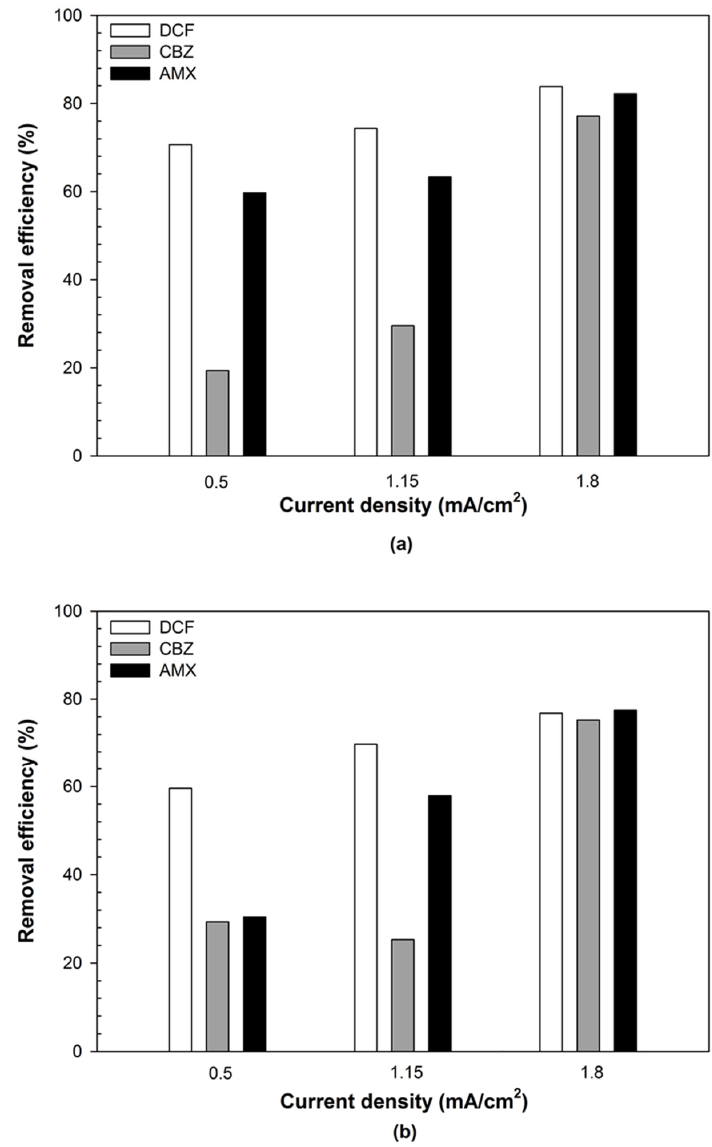
Figure 3. Effects of current density on the removal of pharmaceuticals by electrochemical processes: ( a ) Individual pharmaceuticals; ( b ) Mixture of pharmaceuticals (conditions: initial concentration = 4 mg/L, HRT = 19 h).